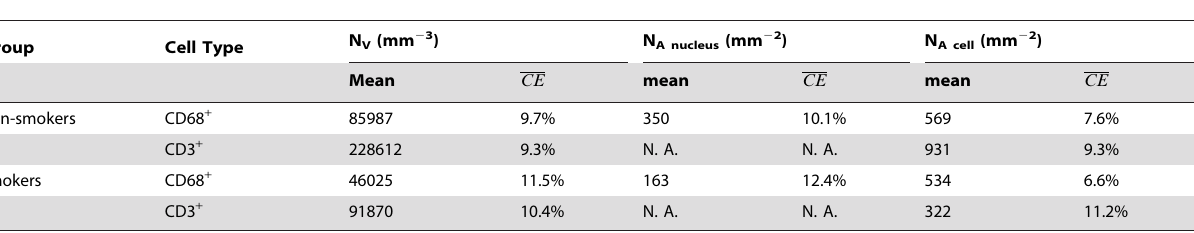
Table 2. Quantitative Morphological Data by Group and Cell Type.